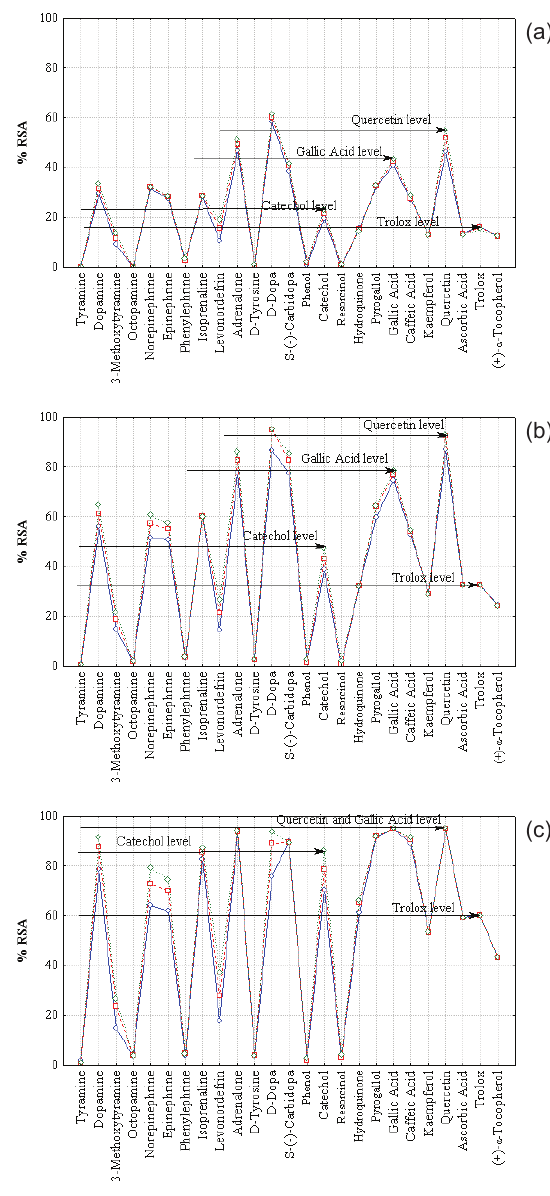
Figure 1. Profiles of the % RSA values for the investigated compounds after different reaction periods ( 10